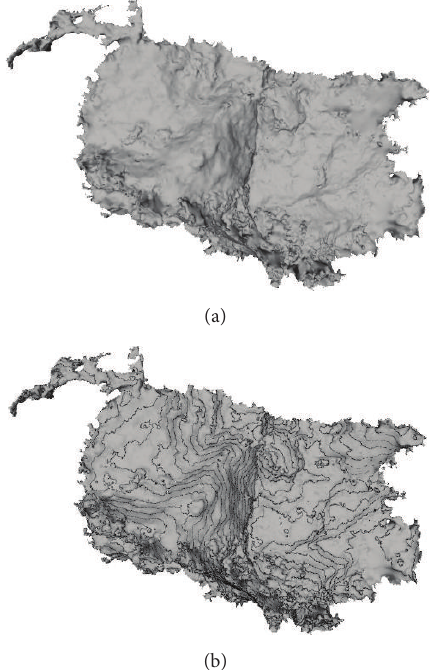
Figure 5: Visualization of the Web3D cave chamber model with 249 934 triangles from a top view perspective (a); and the same 3D mesh with 15 cm equidistant contour lines (b). Note that with the contours information the model highlights the cave relief and preferred alignments.